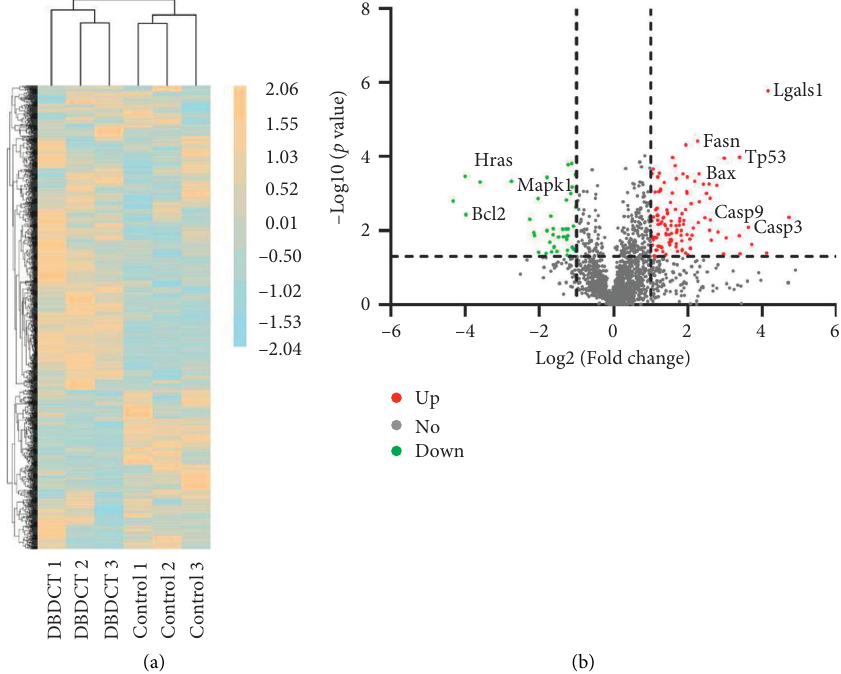
Figure 2: Proteomics analysis of DBDCT-treated rats (5.0mg/kg). (a) Heat map of the significantly expressed proteins in the control and DBDCTgroups. Orange and blue denote high and low expression, respectively. Proteins with similar expression patterns were clustered and are shown as the dendrogram. (b) Volcano plot of differentially expressed proteins in the control and DBDCT groups. Red dots show upregulated proteins, green dots show downregulated proteins, and grey dots show no statistically significant difference between the control and DBDCT